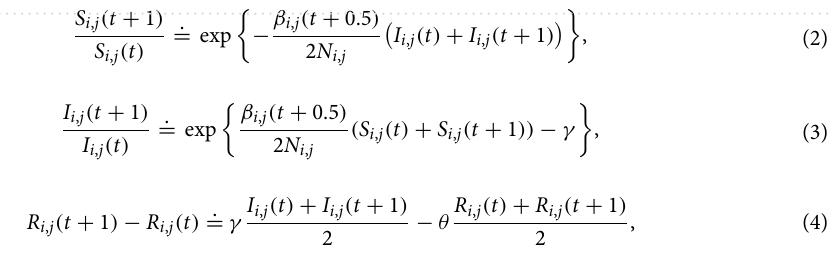
Figure 3. The 21-day forecast in 50 California counties with death toll no less than 2 as of 20 September 2020. The training period is from 21 March 2020 to 20 September 2020, whereas the forecast starts from 21 September 2020. The red curves are the cumulative observed death toll from 21 September 2020 to 11 October 2020 and the blue line indicates the forecast for the same period. The shaded area represents the 95% predictive intervals of the forecast for each analyzed county in